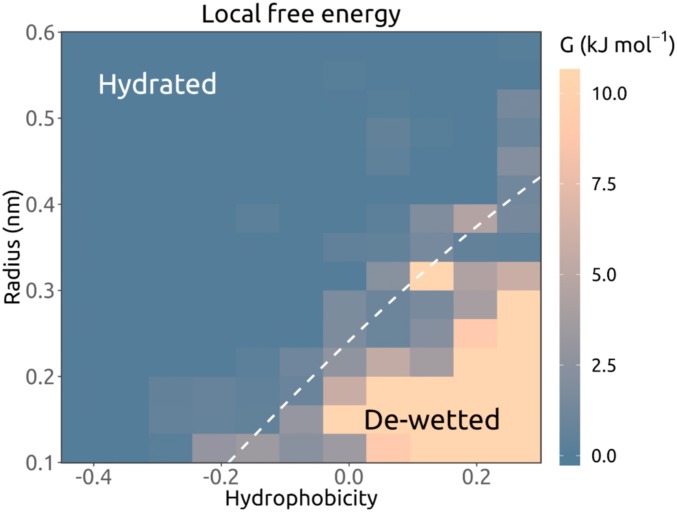
Analysis of all pore-lining residues for a training set of simulated ion channel structures in terms of the local water free energy. From each simulation, mean measurements are noted at the mean position (s) along the pore axis (Fig. 2) of any side chain oriented toward the pore for at least 50% of the simulation. The local water free energy is shown as a function of hydrophobicity and pore radius for all occurrences of pore-lining side chains in the simulated structures. Hydrophobicity values are based on the Wimley–White scale, linearly normalized to [−1, 0.34], in relative units. The hydrophobicity-radius grid is colored by mean energy. Regions with energy values outside the color scale range are shown in the same color as the lower or upper bound. The white dashed contour line indicates the 1 RT (2.6 kJ mol−1) position as given by a polynomial support vector machine classifier.